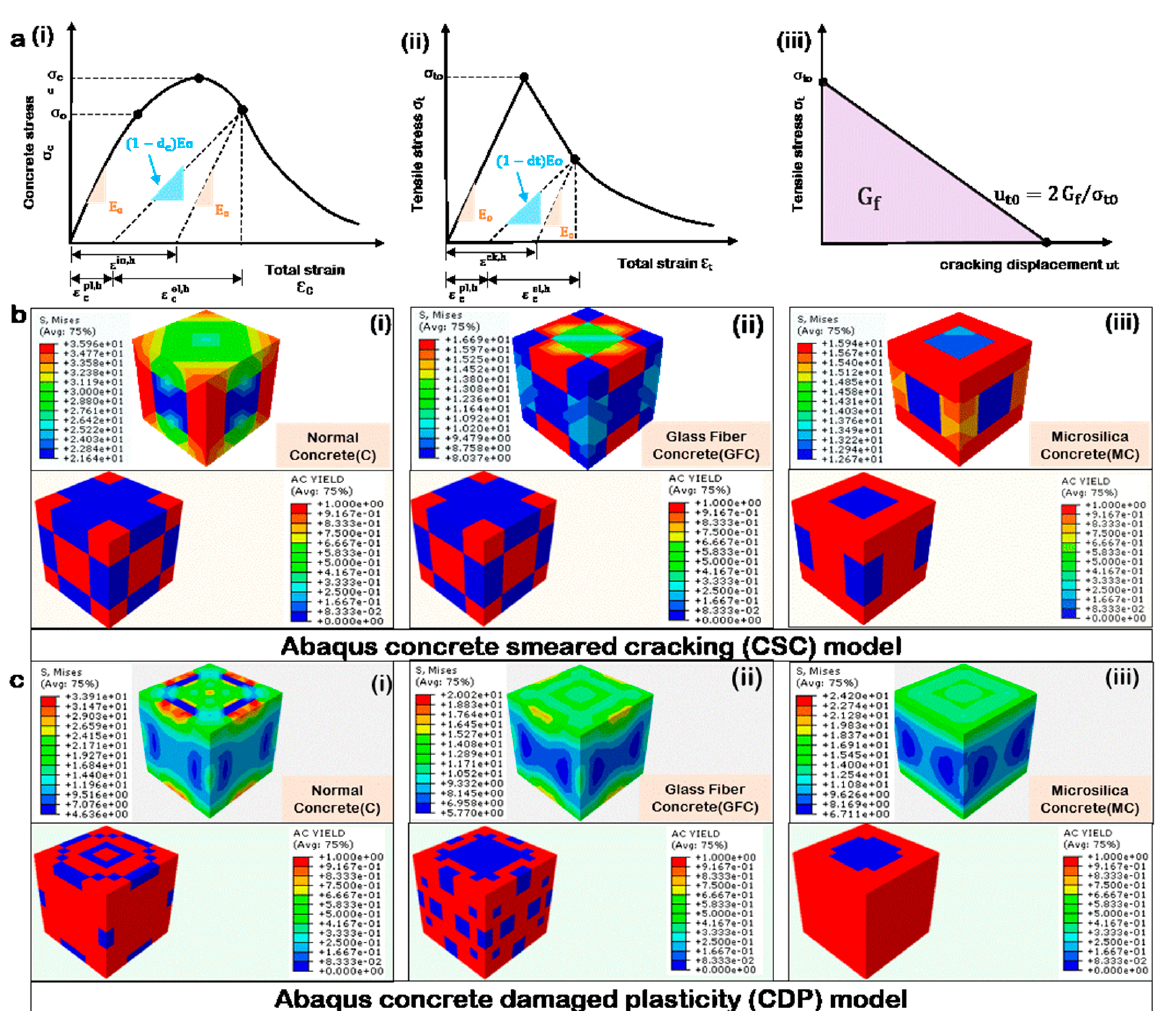
Figure A2. ( a ) The typical response of concrete to uniaxial loading in (i) Compression, (ii) Tension, and (iii) Fracture energy cracking criterion. ( b ) Failure stress and yield results for CSC model of (i) C, (ii) GFC-1, and (iii) MC-2. ( c ) Failure stress and yield results for CDP model of (i) C, (ii) GFC-1, and (iii) MC-2.